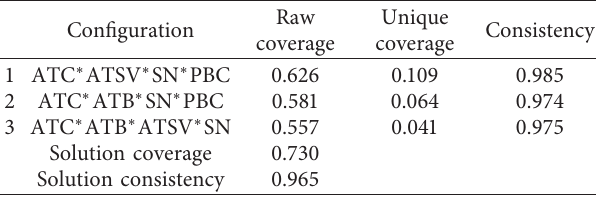
Table 8: Combinations of sufficiency